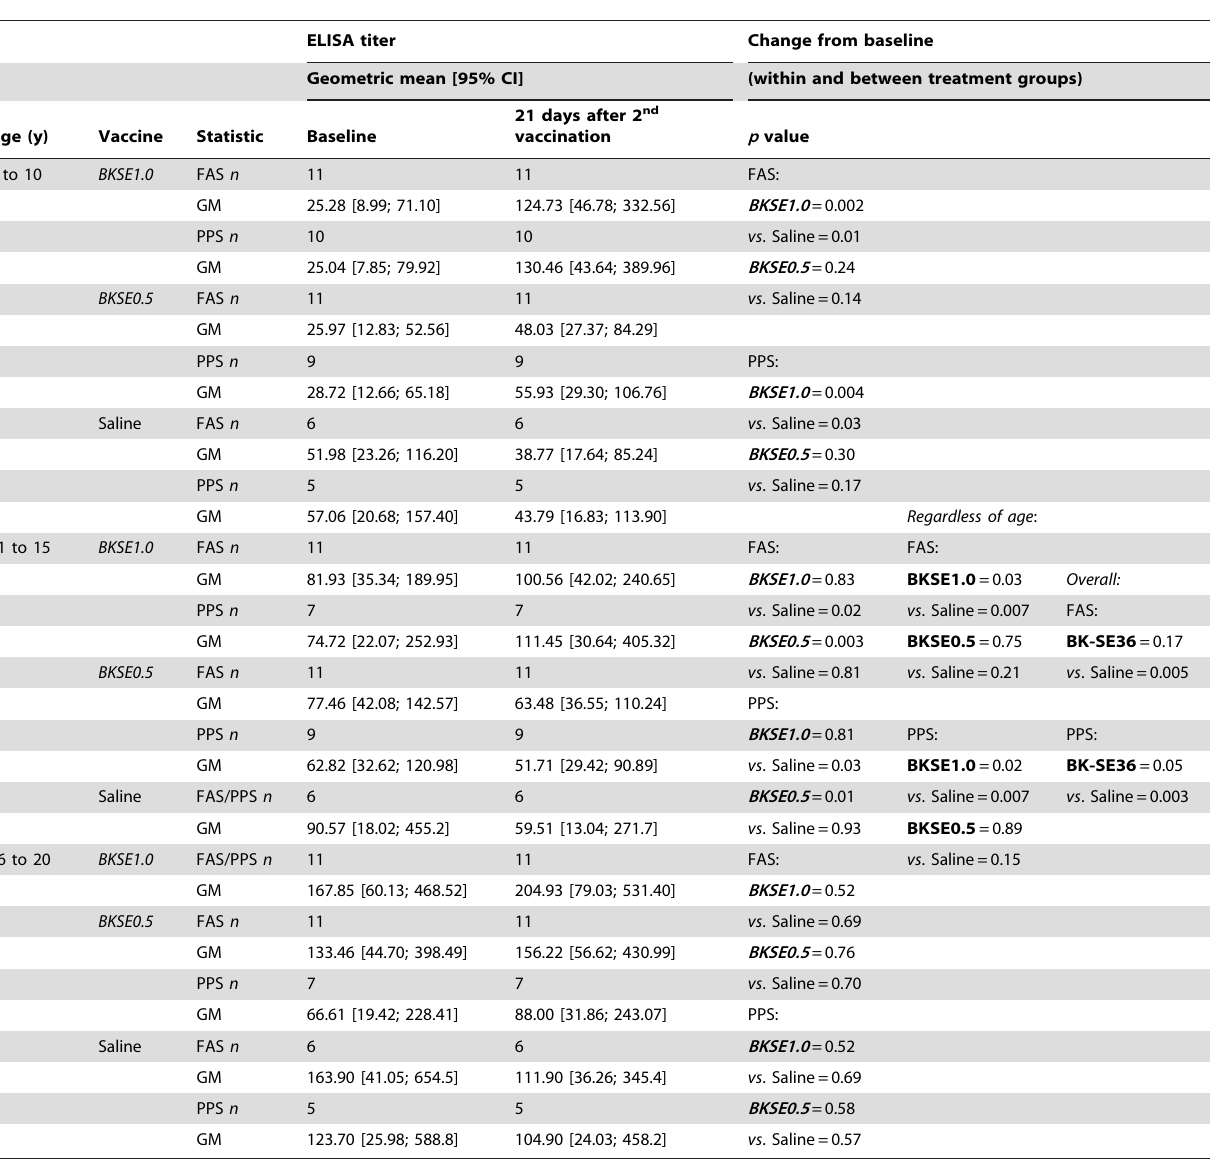
Table 5. Anti-SE36 antibody titers pre-vaccination (baseline) and 21 days post-second vaccination in Stage2.